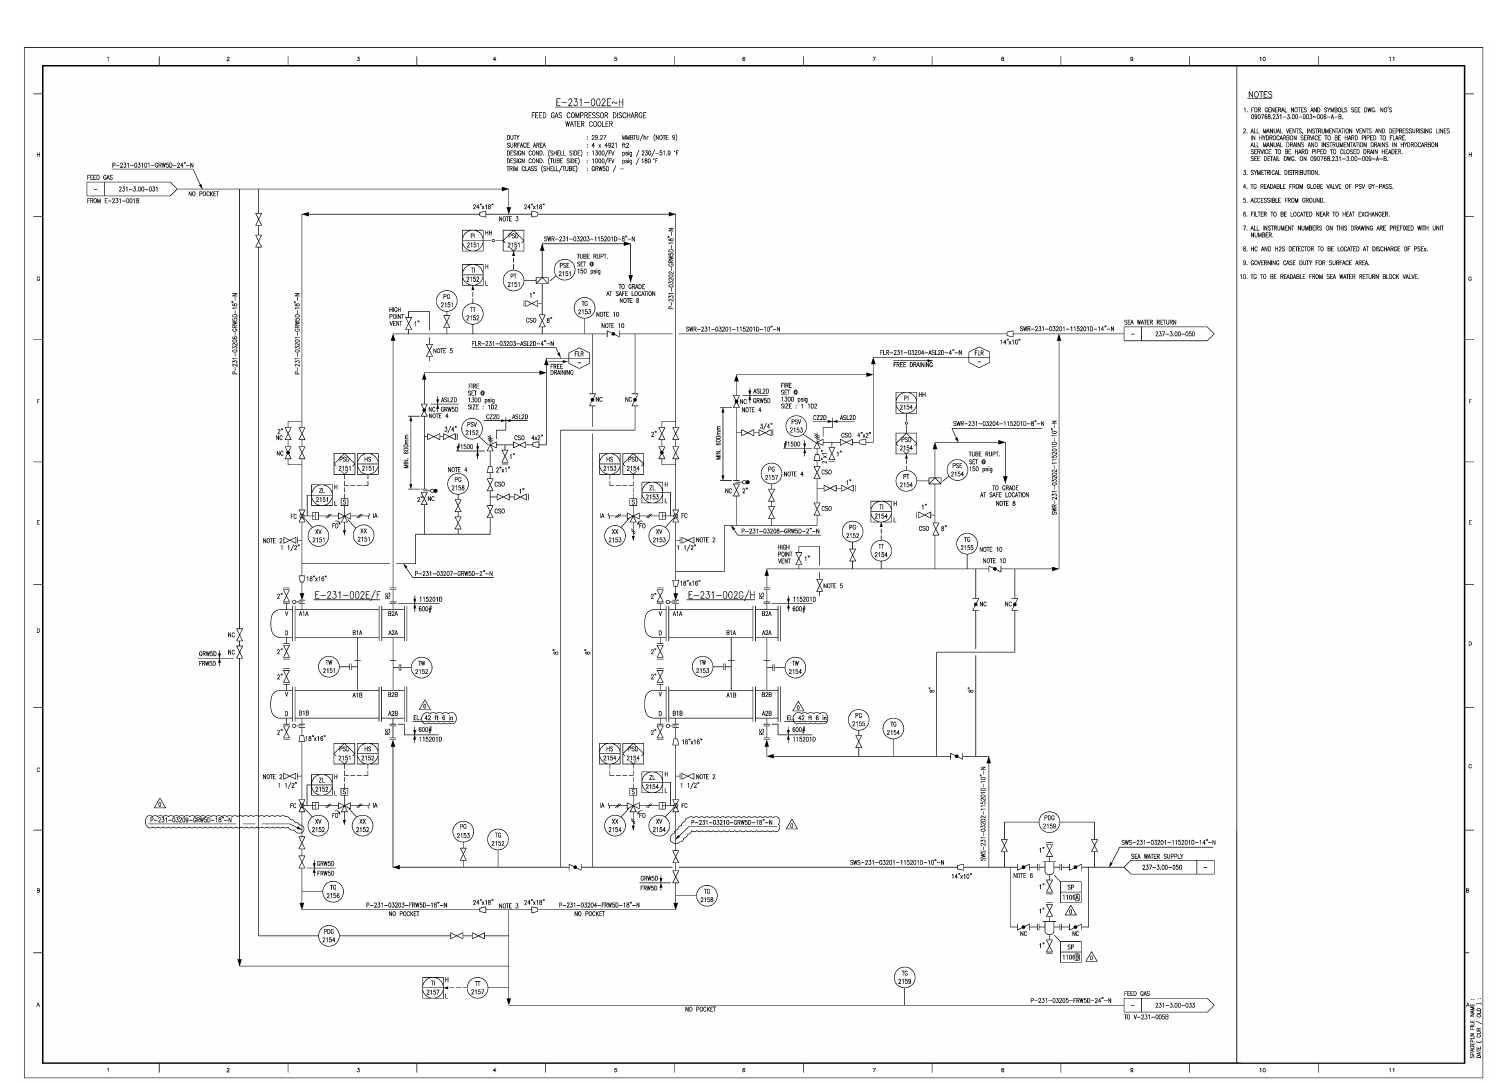
Figure 4. Cannabidiol (CBD) content in the inflorescences. Means with the same letter are not significantly di ff erent. LSD at 5% level. Bars represent standard error. Figure 9. An example of a P&ID of a liquefied natural gas plant converted from computer-aided design (CAD) to portable document format